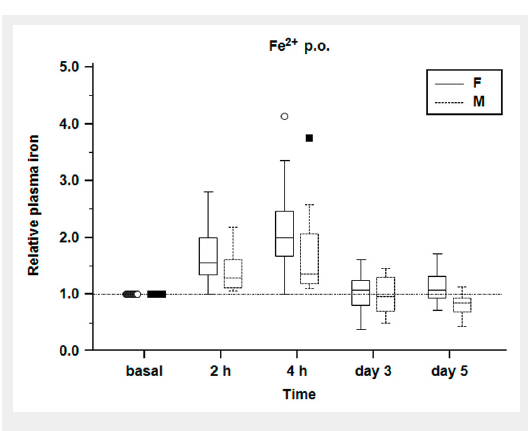
Absolute plasma iron concentration. Box and whiskers plot representing the median, first and third quartiles and the range of plasma iron concentration after ingestion of bivalent ferrous fumarate. Outliers are shown as circles (females) and squares (males).